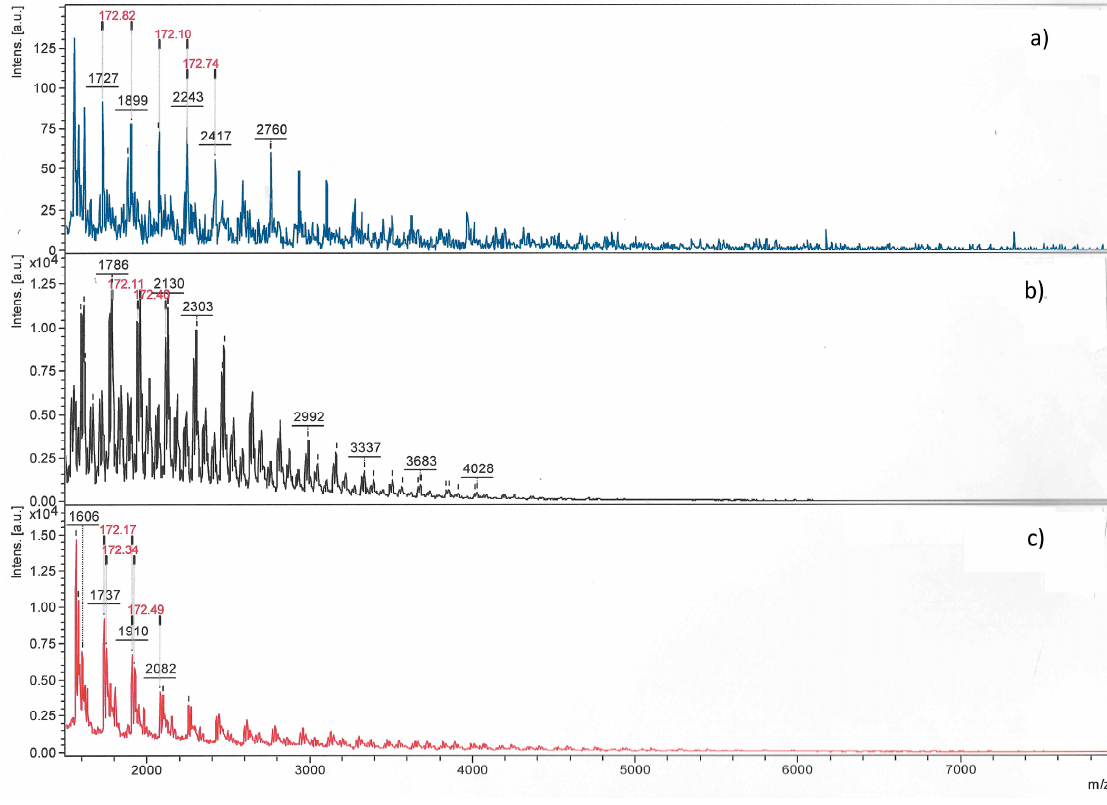
Figure 4. MALDI/TOF-MS spectra of PBS ( a ) PBS1-2 obtained by conventional transesterification with Ti(OBut) 4 ; ( b ) PBS7 obtained with CALB in melt with low molar mass, and ( c ) PBS5 obtained with CALB in solution with high molar